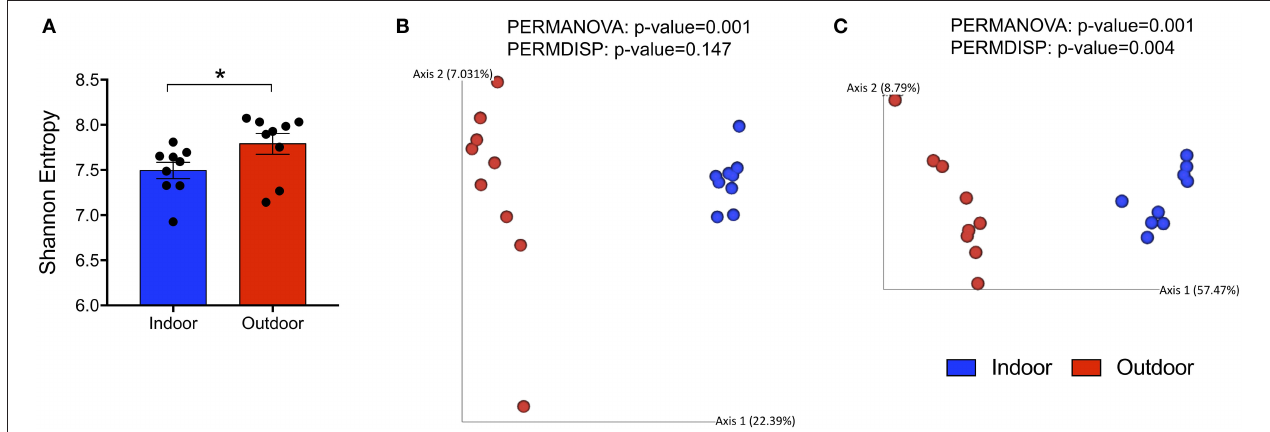
FIGURE 1 | Global changes in structure and composition of cecal bacterial communities from indoor to outdoor rearing system. (A) Bar-dot plot showing Shannon Index as a measure of intra-group bacterial diversity (mean ± SEM; * p < 0.05). (B,C) Principal coordinate analysis (PCoA) plots based on unweighted and weighted UniFrac distances (5,766 sequences/sample), with the amount of variance along each axis in brackets. On the top of each PCoA plot are reported p -values of the PERMANOVA and PERMDISP tests used to estimate the significant differences in microbial community composition between the groups.